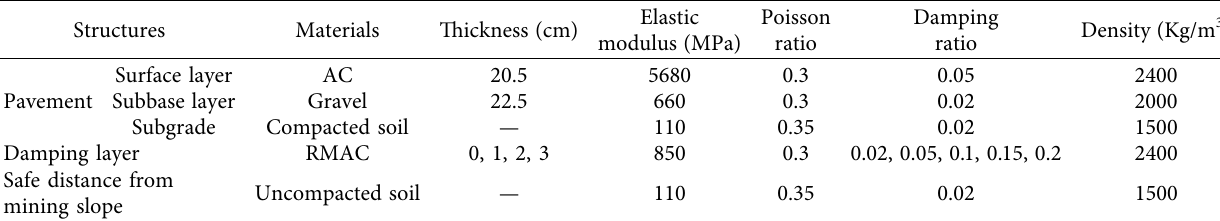
Figure 1: Schematic diagram of the finite element (FE) Table 1: Mechanical properties used for the FE simulations.